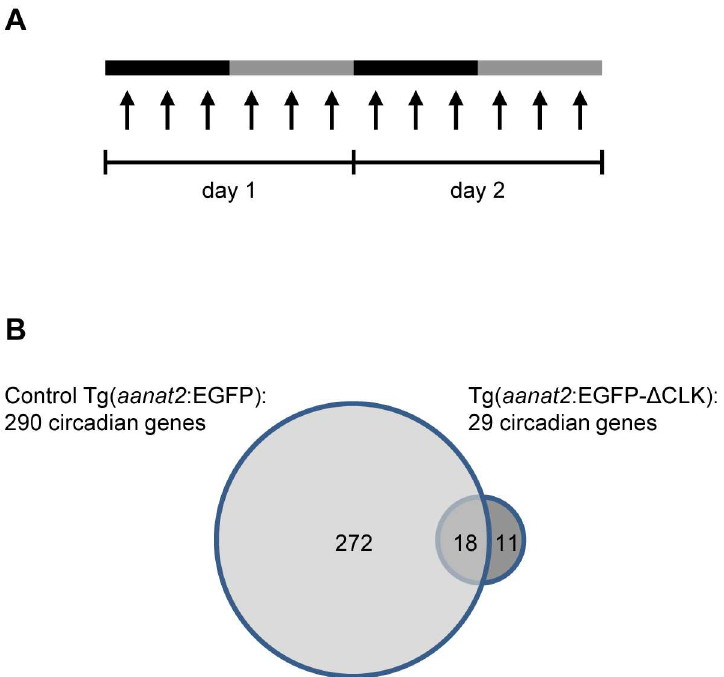
Fig 4. Clock-controlled rhythmic gene expression is disrupted in Δ CLK-expressing pineal glands. (A) Experimental procedurefor transcriptome analysis. Adult fish were kept under DD and pinealglandswere sampledat 12 time points (indicated by arrows) throughouttwo daily cycles. Black and gray bars correspond to subjective night and day, respectively. (B) The mRNA-seq analysisresulted in the identification of 29 circadiangenes in the pinealglandof Tg( aanat2 :EGFP- Δ CLK) fish comparedwith 290 circadiangenes in the pinealgland of Tg( aanat2 :EGFP) control